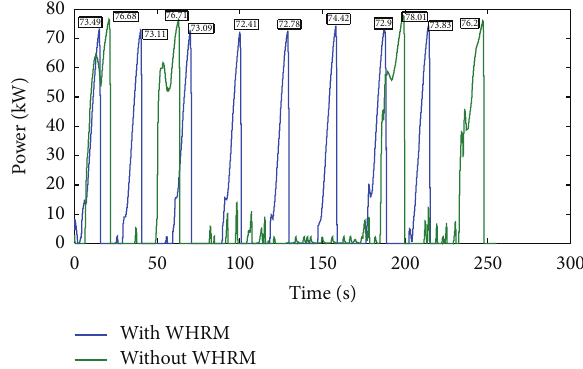
Figure 8: Power of the experimental vehicle with and without WHRM (value in kW).